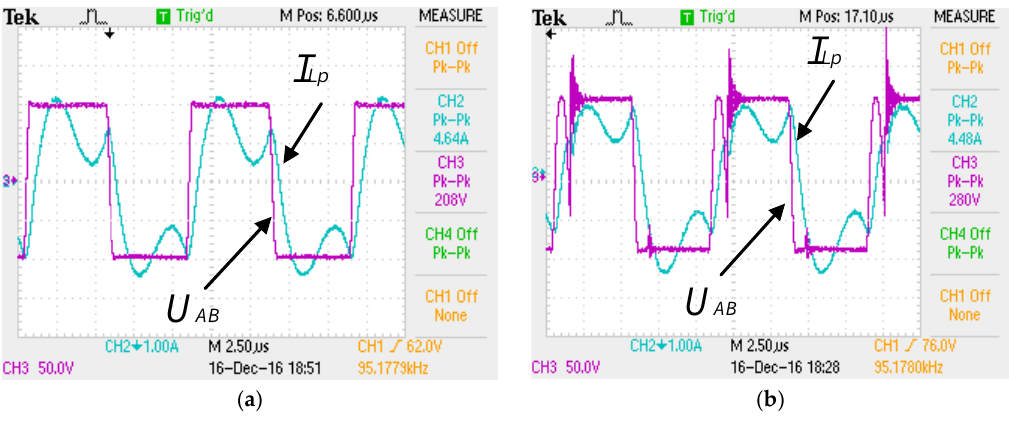
Figure 7. Voltage and current of inverter ( a ) t DT = 500 ns; ( b ) t DT = 1.2 us.